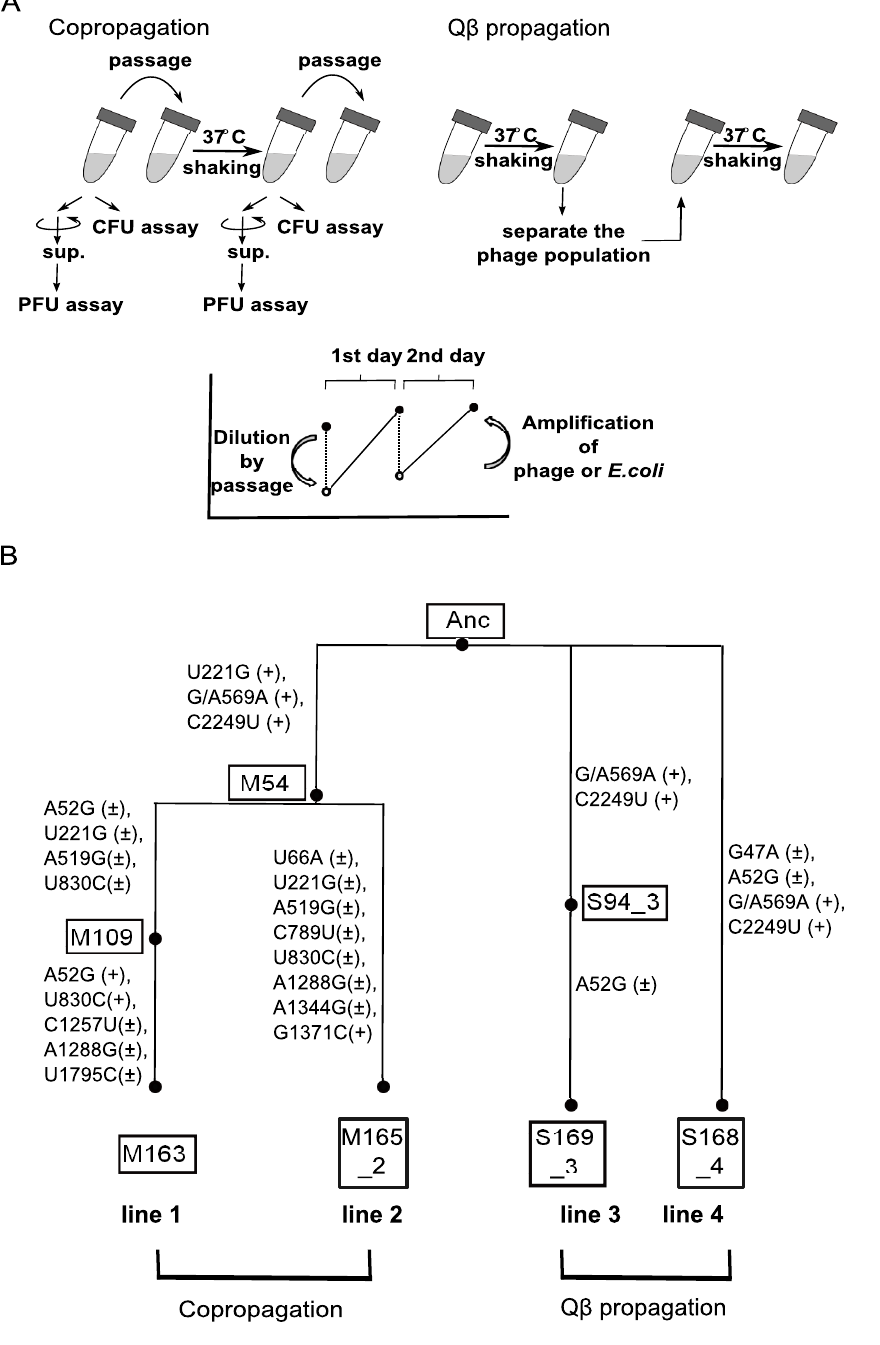
Figure 1. Model evolution system. (A) In the copropagation regime, cultures including E. coli and Q b were passaged into fresh medium every day. In the Q b propagation regime, only Q b was isolated and used to infect fresh growing Anc(C). The values of PFU/ml or CFU/ml of cultures incubated for about 24 h (copropagation regime) or about 6 h (Q b propagation regime) were determined. The concentration of Q b and/or E. coli decreased by dilution in passage and increased by amplification or growth. (B) Phylogeny and nomenclature of the experimental lineages used in this study. Copropagation was conducted in two lines designated as lines 1 and line 2. Q b propagation was conducted independently in two lines: line 3 and line 4. The ancestral organisms were designated as Anc. The M and S represent the sample of copropagation and Q b propagation lines, respectively. The numbers in the boxes represent the replication generation numbers of Q b , and the numbers after the underbar represent the lineage line number. The mutations observed in the Q b genome in both propagation experiments are shown in the order of the sequence of the ancestral Q b genome, position on the genome, and the sequence of the evolved genome. The + and 6 in parentheses represent monomorphic and polymorphic sequences, respectively. Position 569 of Anc was heterogeneous with G and A, although the Anc Q b population was derived from cloned cDNA.